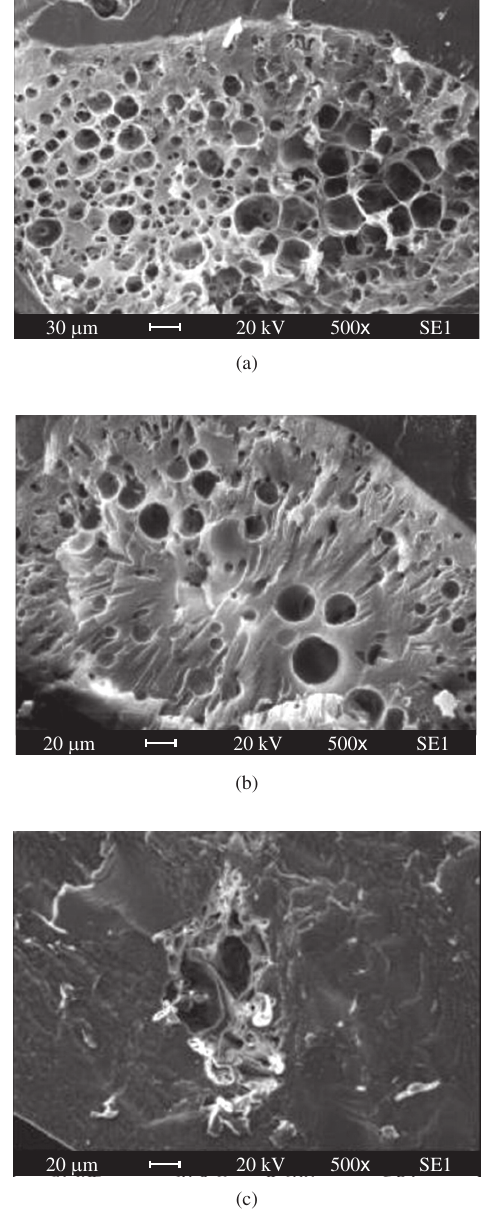
Figure 8. a) Scanning electron micrograph of epychlorohydrin-treated chitosan microsphere fracture; b) Scanning electron micrograph of glutaraldehyde-treated chitosan microsphere fracture; and c) Scanning electron micrograph of chitosan microspheres cross section morphology modified with acetic